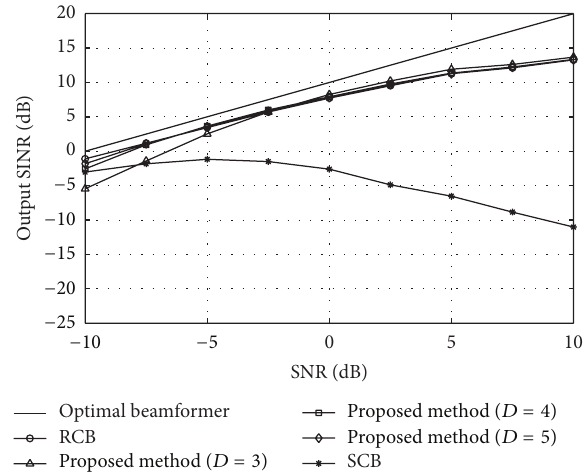
Figure 2: Output SINR of the beamformers versus input SNR.